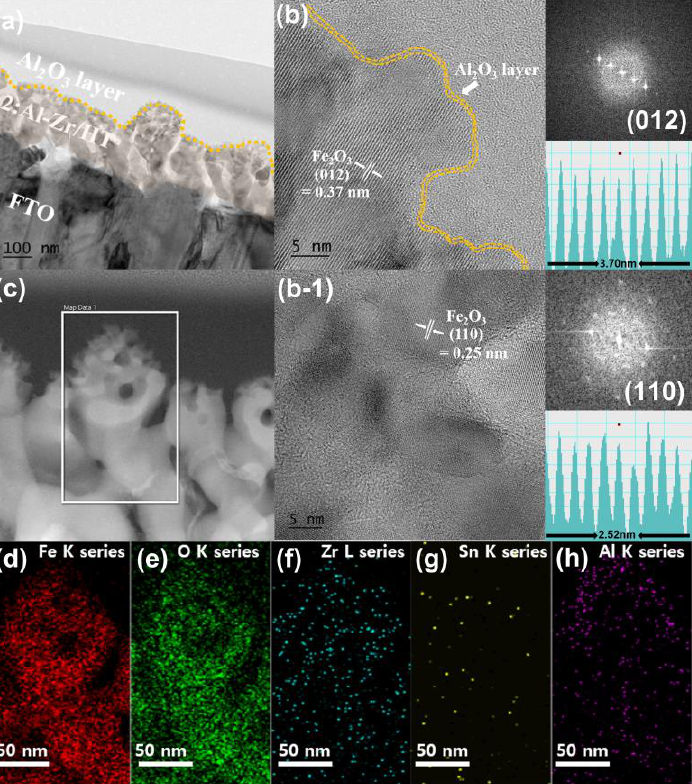
Figure 5. ( a ) FIB-low magnification TEM image, ( b , b-1 ) high resolution-TEM image (Inset: corre- sponding selected area electron diffraction (SAED)), ( c ) HAADF−STEM image, and EDS elemental mapping images of ( d ) Fe, ( e ) O, ( f ) Zr, ( g ) Sn, and ( h ) Al elements of the optimized 2:Al-Zr/HT photoanode.